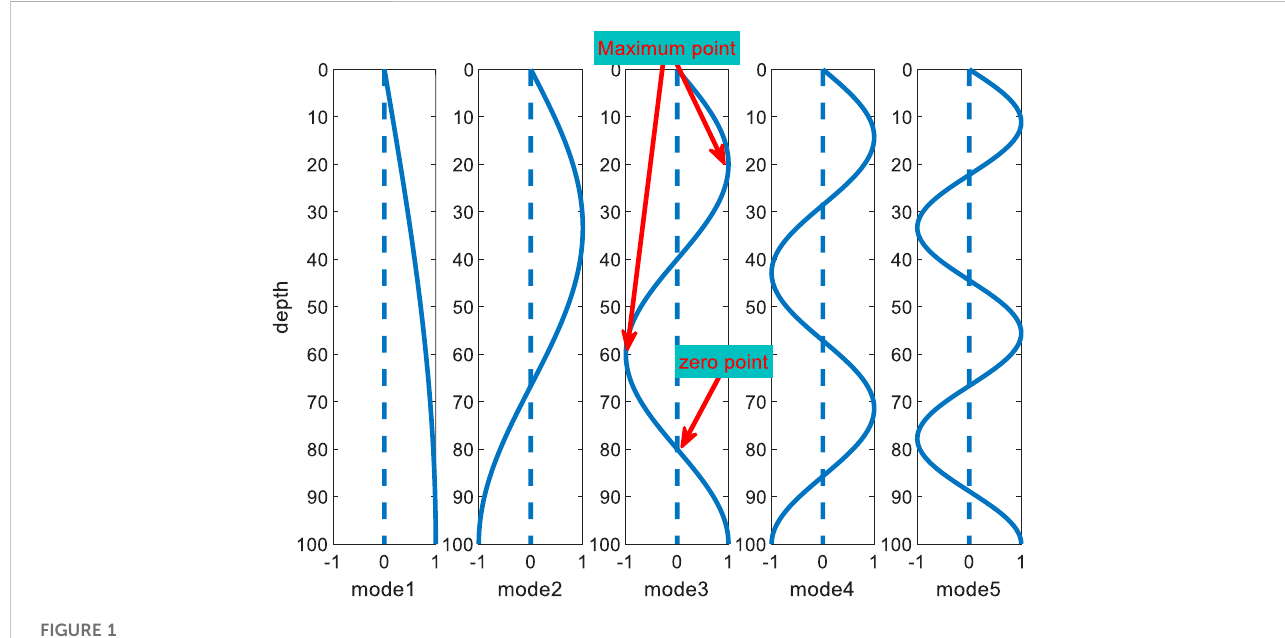
FIGURE 1 Normalized amplitude distribution of normal modes with depth.